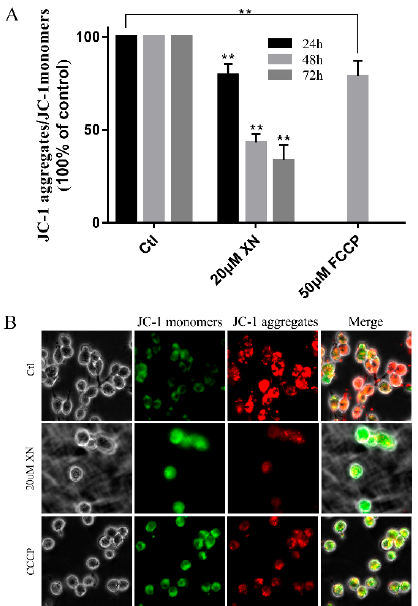
Figure 6. XN (20uM) affected the MMP of C6 cells. ( A ) The C6 cells were treated with XN for the indicated different times or 50 µ M FCCP for 2 h. The cells were incubated with JC-1 for 30 min